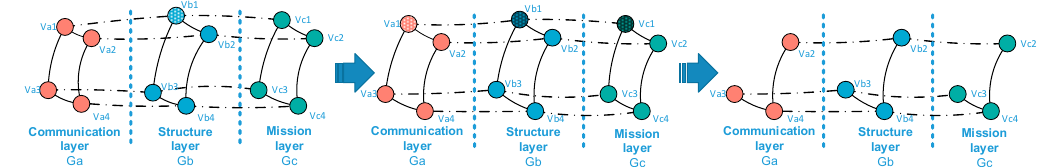
Figure 3. Interlayer relationships between the communication layer and structure layer.